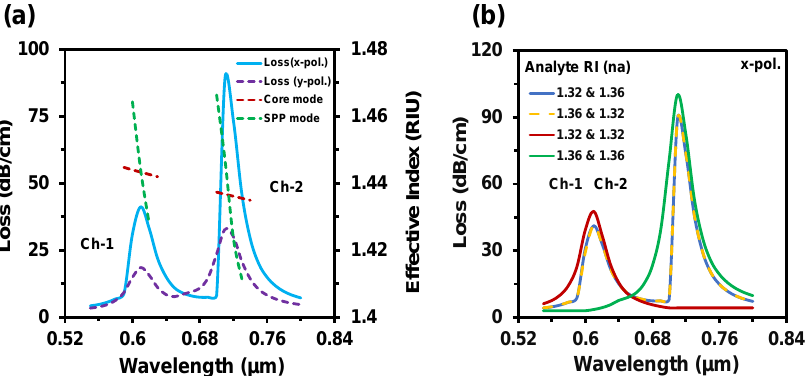
Figure 4. ( a ) The dispersion relationship of the proposed sensor for n a = 1.32 & 1.36 and ( b ) analyte channels dependency behavior at analyte RI of 1.32 and 1.36. Figure 4b represents the sensing channels’ dependency on the analyte RI variation. To investigate the channel characteristics, firstly we set RI 1.32 for Ch-1 and RI 1.36 for Ch-2. The proposed sensor showed resonant wavelengths at 610 nm and 710 nm, respectively, for Ch-1 and Ch-2. Additionally, the sensor showed the same spectrum with the same resonant wavelength while switching the analyte to RI 1.36 for Ch-1 and RI 1.32 for Ch-2. To further investigate the channel effect, we infiltrated the same analyte RI in both